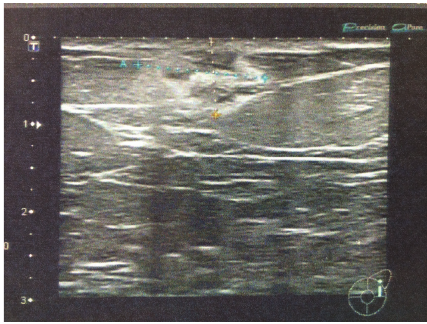
Figure 3: Ultrasound: heterogeneous oval mass with echogenic rim; BI-RADS